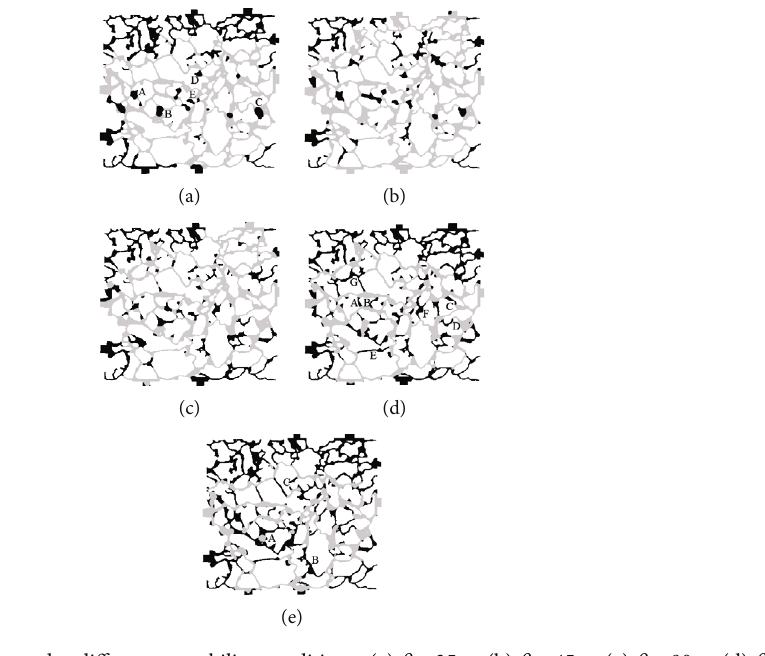
Figure 9: Final oil-water distribution under di ff erent wettability conditions: (a) θ = 25 ° ; (b) θ = 45 ° ; (c) θ = 90 ° ; (d) θ = 125 ° ; (e) θ = 165 °